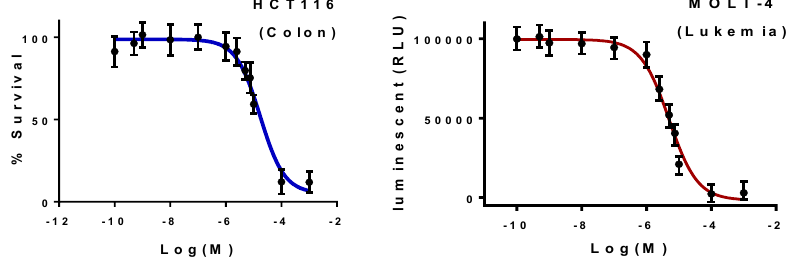
Figure 3. Representative IC 50 fitting curves: effect of active isosteviol conjugate 12a on the colon (HCT116) using MTT assay and leukemia (MOLT-4) using CellTiter-Glo ® Luminescent Cell Viability Assay.